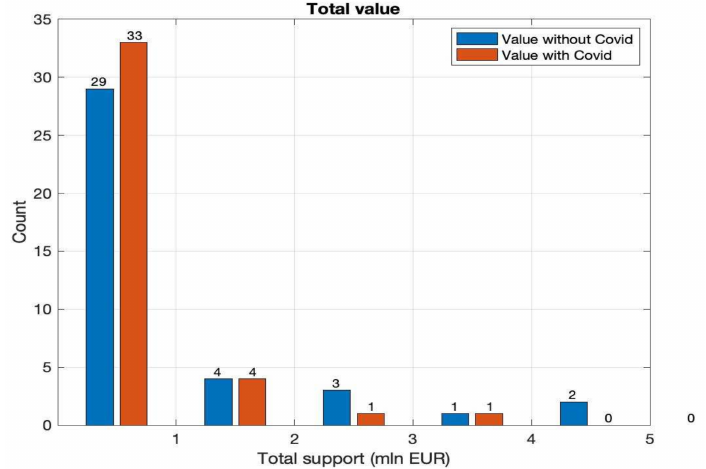
Figure 5. Support for hospitals and health care units under Regional Operational Programme for the Opolskie Voivodeship RPO WO 2014–2020.